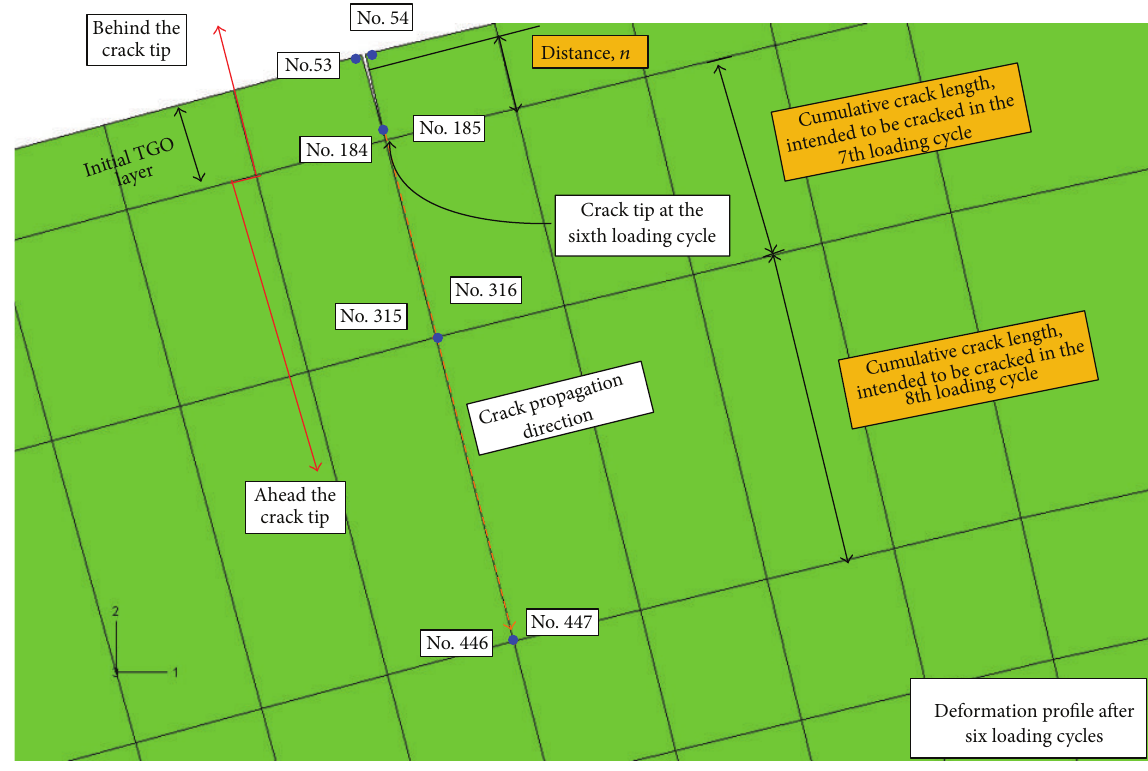
Figure 13: The determination to input parameters of CCOD for simulating crack propagation after six loading cycles.